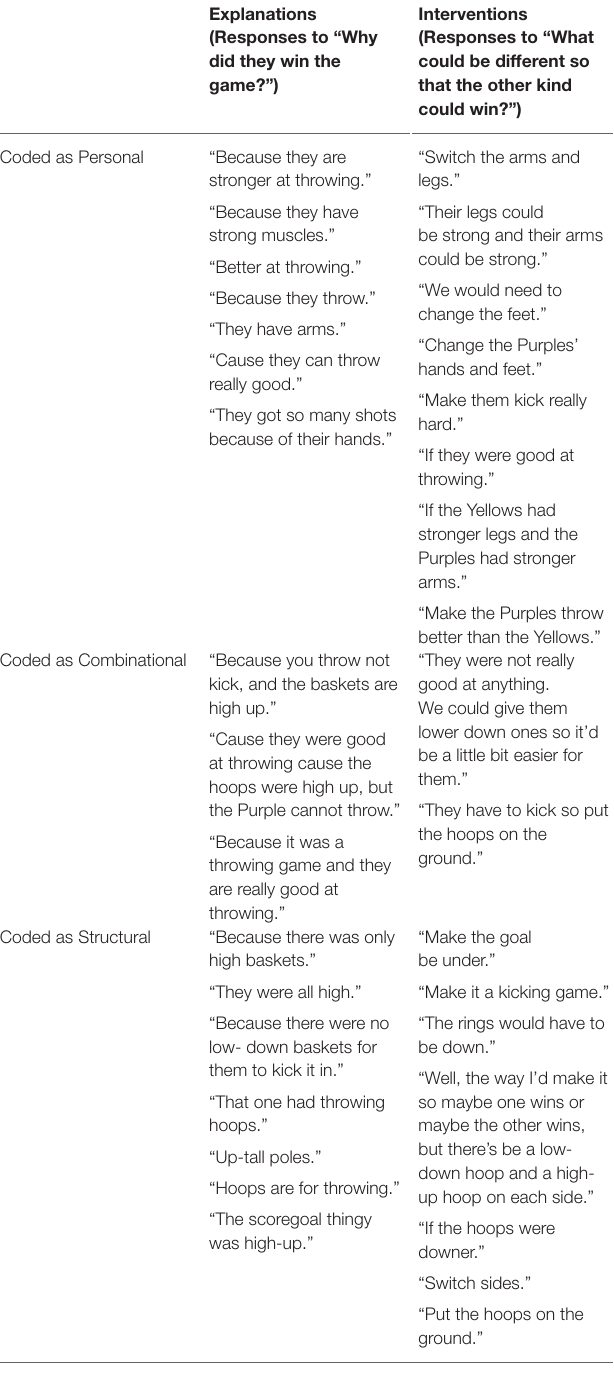
TABLE 1 | Examples of responses coded as personal, combinational, and